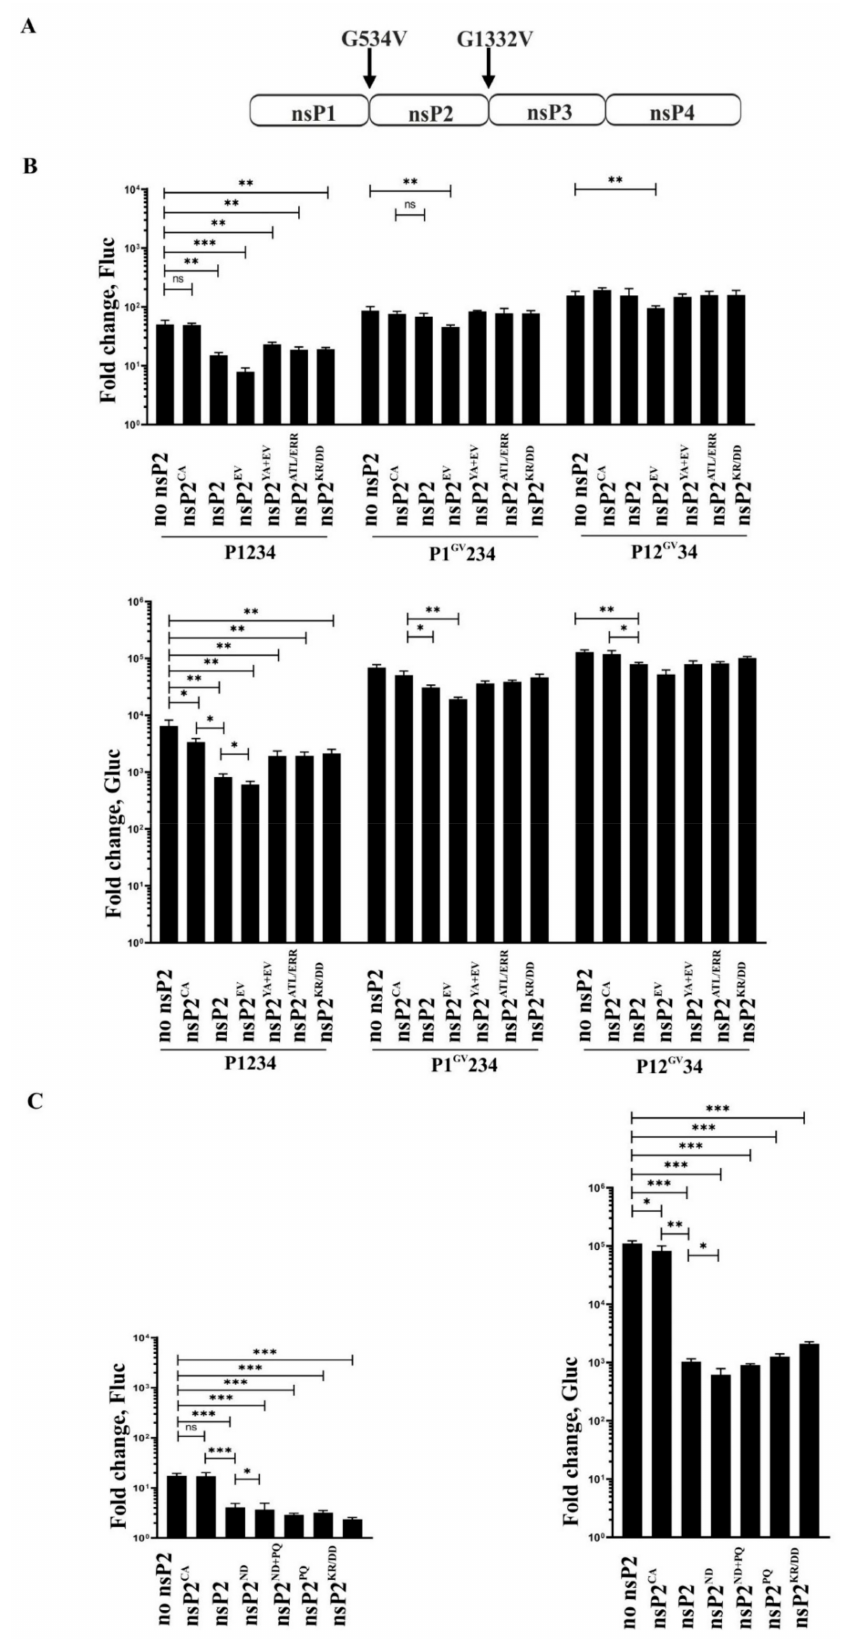
Figure 2. Co-expression of CHIKV and SINV nsP2 inhibits activity of trans–replicase of homologous virus. ( A ). Mutations introduced to ns-polyprotein of CHIKV. Mutation G534V leads to